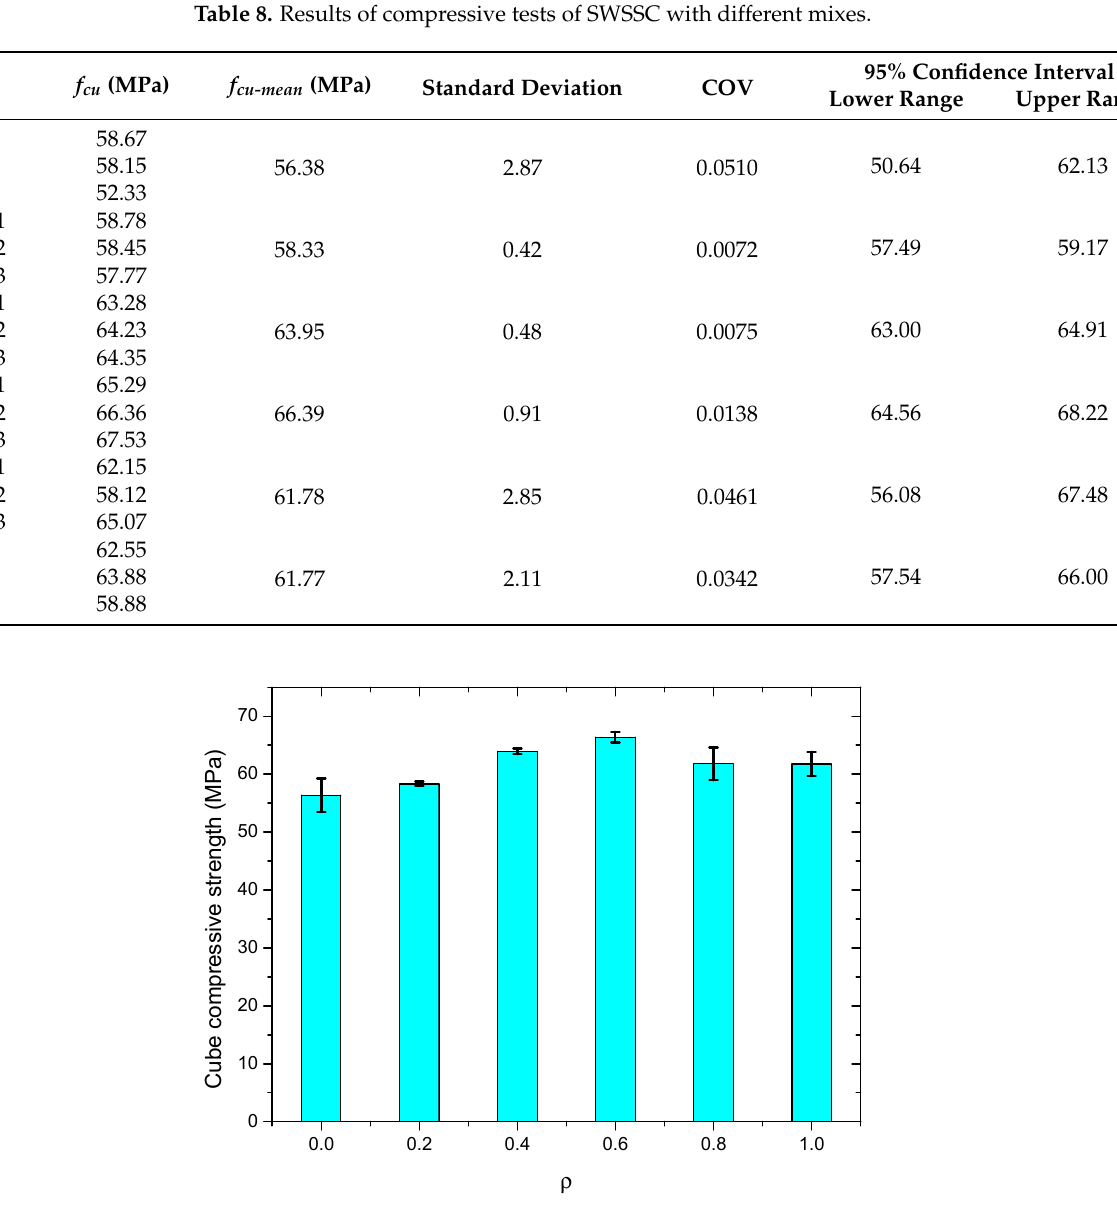
Figure 9. f cu of SWSSC specimens with different ρ .